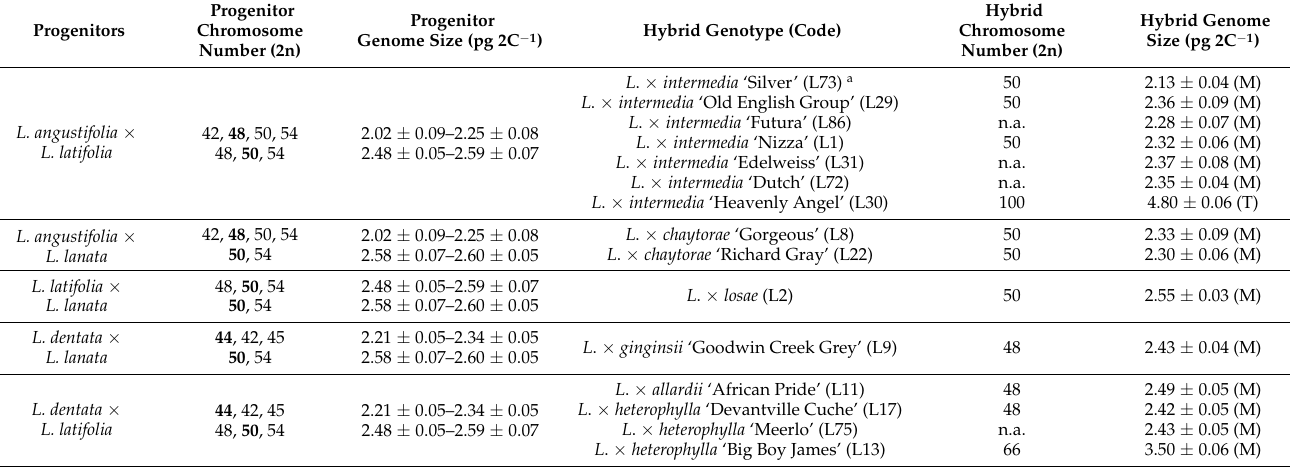
Table 1. Inter- and intrasectional hybrids together with progenitor background and the hybrids’ respective chromosome number and genome size. Progenitor chromosome numbers mentioned are numbers found in literature and own counts. Chromosome numbers in bold indicate the values both found in our study and in literature. The genome sizes of the progenitors are given as a range based on genome size measurements from our study in 28 L. angustifolia , 6 L. latifolia , 7 L. dentata and 2 L. lanata genotypes. The standard deviation on genome size measurements and plant species used as internal standard are mentioned next to the 2C values ( Zea mays (M), Solanum lycopersicum (T)). n.a. = not